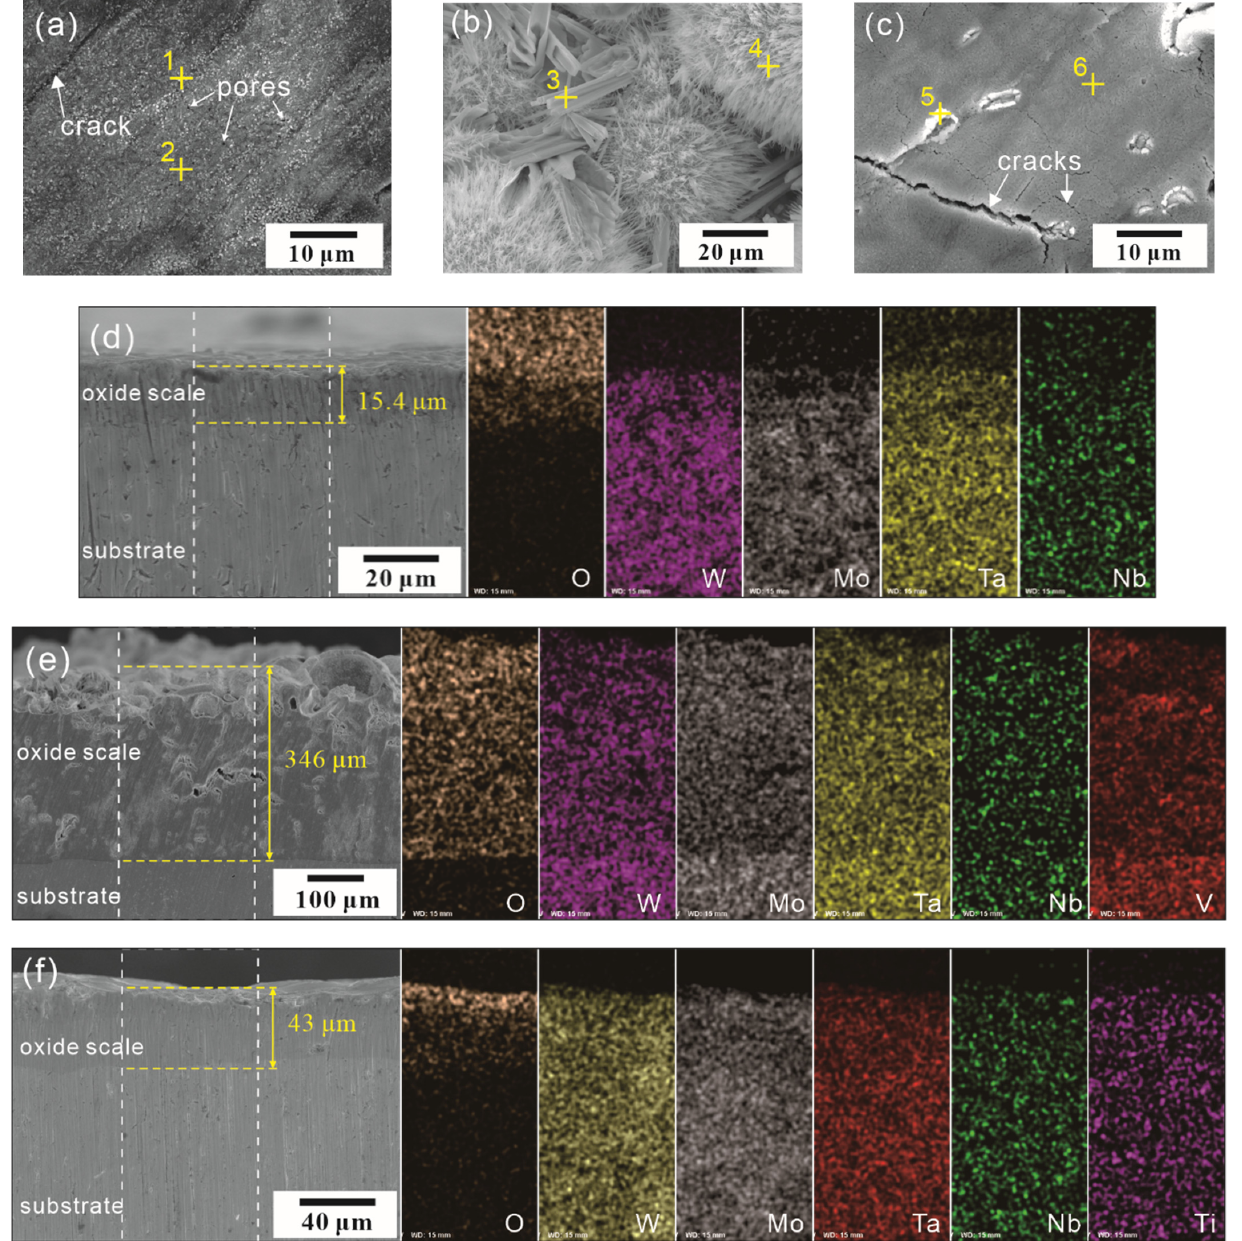
Figure 4. Surface morphologies, cross sections and EDS results of ( a , d ) WMoTaNb, ( b , e ) WMoTaNbV and ( c , f ) WMoTaNbTi RHEAs after 0.5 h of oxidation at 1000 °C.